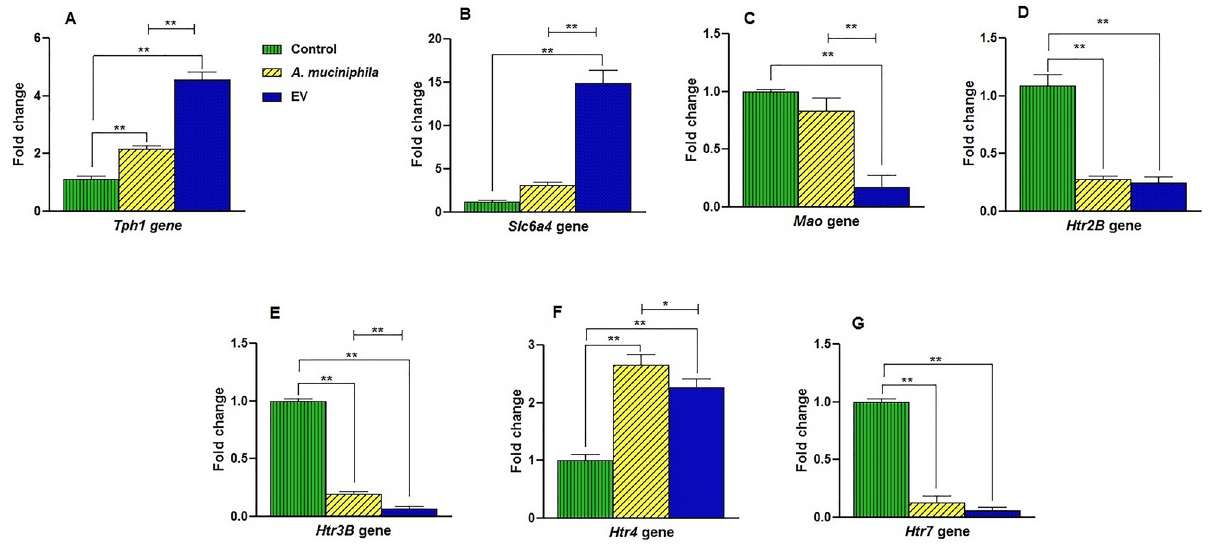
Figure 3. The effects of treatment with A. muciniphila and its EVs on the expression level of genes involved in the peripheral serotonergic system in the colon of mice. After 4 weeks of treatment, the relative mRNA expression in the colonic tissue of mice was affected by both the bacterium and its EVs. Expression of ( A ) Tph1 ( B ) Slc6a4 ( C ) Mao ( D ) Htr2B ( E ) Htr 3B ( F ) Htr 4, and ( G ) Htr 7 genes. Data are normalized using RPL13a and β-actin as control genes. *, **, ’P < 0.05 and P < 0. 01 was considered statistically significant, respectively.